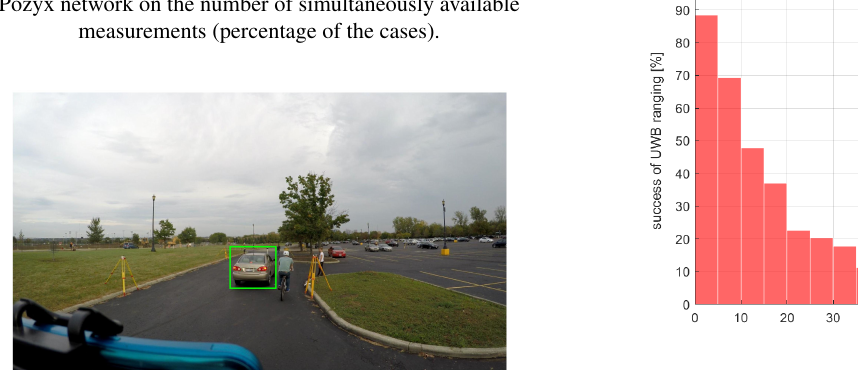
When one V2V UWB range measurement r is available, between the GPSVan and the detected car, the relative posi- tion of the detected car with respect to the GPSVan is estimated by computing the intersection between the line passing through the GoPro optical center and identified by the angle α and the circle corresponding to the distance r from the UWB device that provided the measurement r .